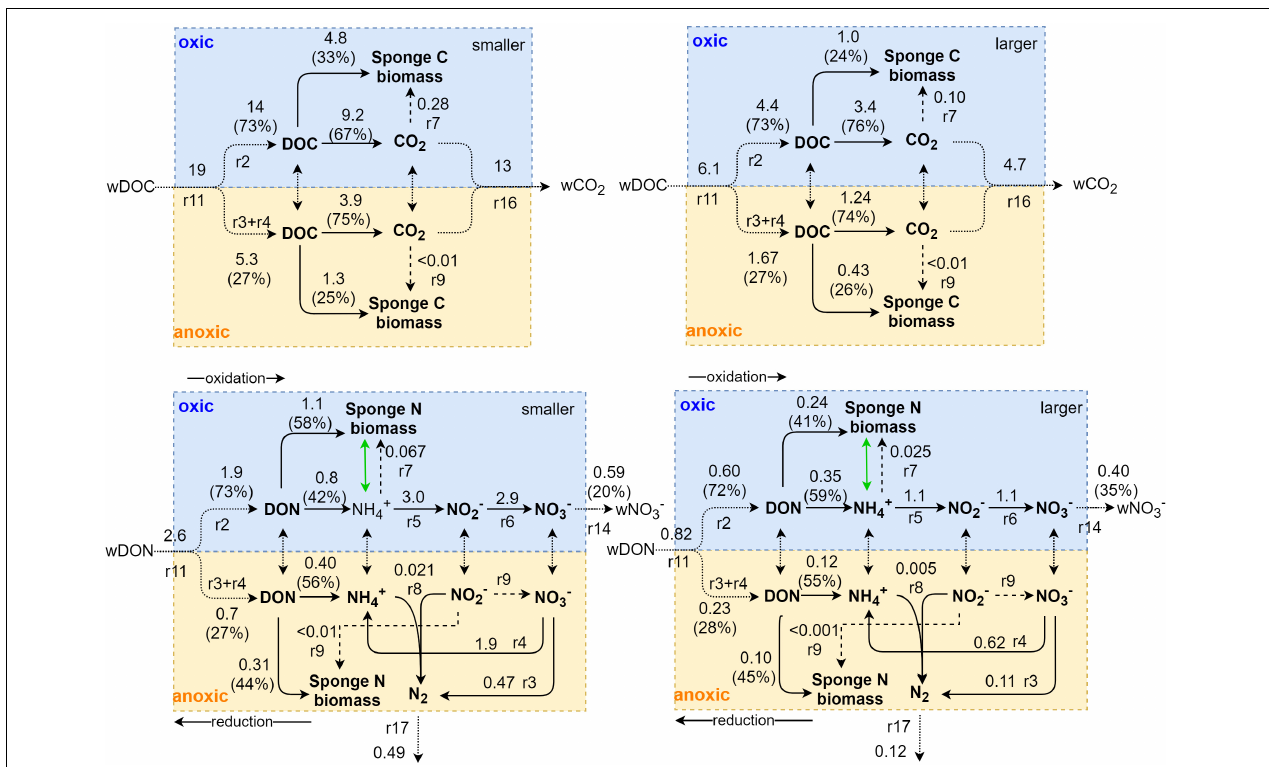
FIGURE 6 | Schematic representation of internal C and N metabolism in Geodia barretti. Metabolic processes are indicated with solid arrows with reaction (r) numbers corresponding to those of Figure 2 and Table 2 . Aerobic and anaerobic processes are separated in the blue and yellow part, respectively. Exchange fluxes are shown with dotted arrows. Model-calculated average metabolic rates in µ mol C cm − 3 day − 1 or µ mol N cm − 3 day − 1 , shown adjacent to arrows, differ between smaller and larger G. barretti (right). The partition of dissolved organic matter to oxic and anoxic processes and to (C and N) sponge biomass production and respiration are shown with percentages. Dashed arrows indicate chemoautotrophic processes. Internal NH 4 + excretion and re-assimilation, shown by the green arrow, is expected to take place but is not explicitly modeled. Bacteria uptake (r1) and NO 2 − (r15) and NH 4 + (r13) exchange are not shown for